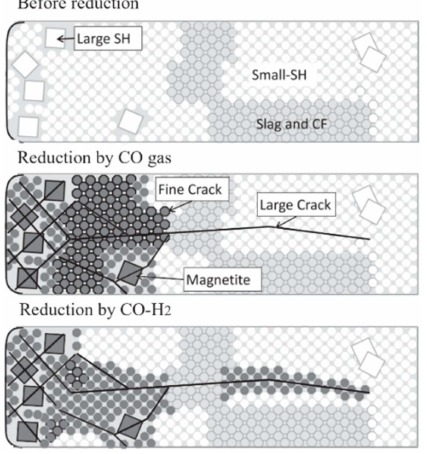
Figure 1. Reduction disintegration mechanism of sinter, adopted from [32]. SH: Skeletal hematite; CF: multi-component calcium